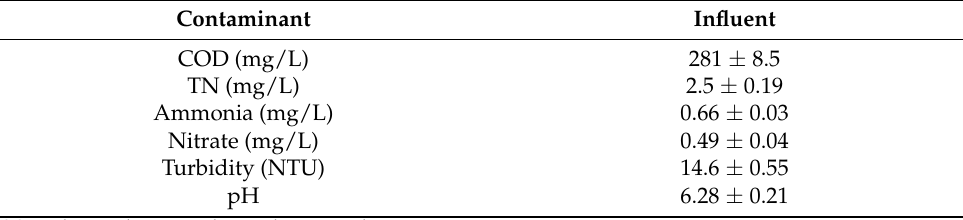
Table 1. Influent wastewater